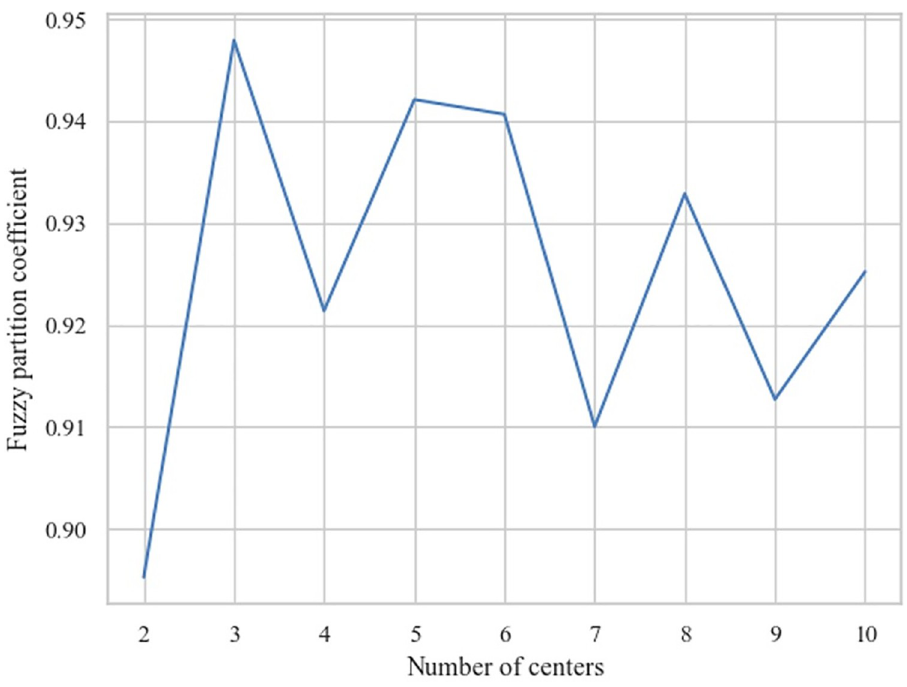
Fig 2. The comparison of the fuzzy partition coefficient (FPC) for the selecting centers of FCM.